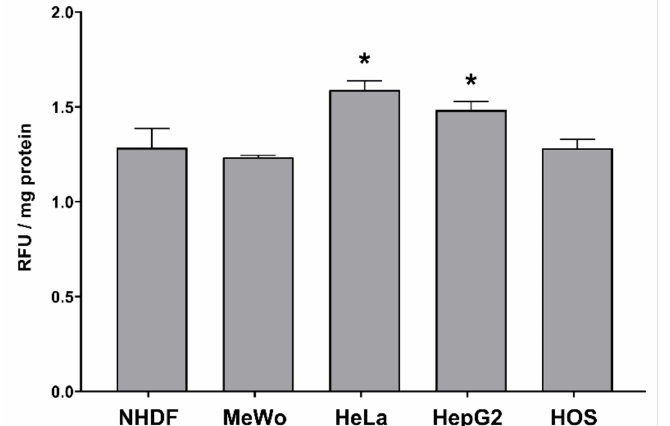
Figure 11. Intracellular H 2 O 2 production in normal dermal fibroblasts (NHDF), malignant melanoma (MeWo), adenocarcinoma (HeLa), hepatocellular carcinoma (HepG2) and osteosarcoma (HOS) cells treated with cell line-specific IC 50 doses of CBD-enriched hemp oil for 24 h. Control cells were incubated with complete cell culture medium. Experiments were done in triplicate, obtained data were expressed as relative fluorescence units (RFU)/mg protein, expressed as fold change of control values and represented as means ± standard error of the mean. * p < 0.05 vs. control cells (NHDF p = 0.058216, MeWo p = 0.160015, HeLa p = 0.011617, HepG2 p = 0.020345, HOS p =